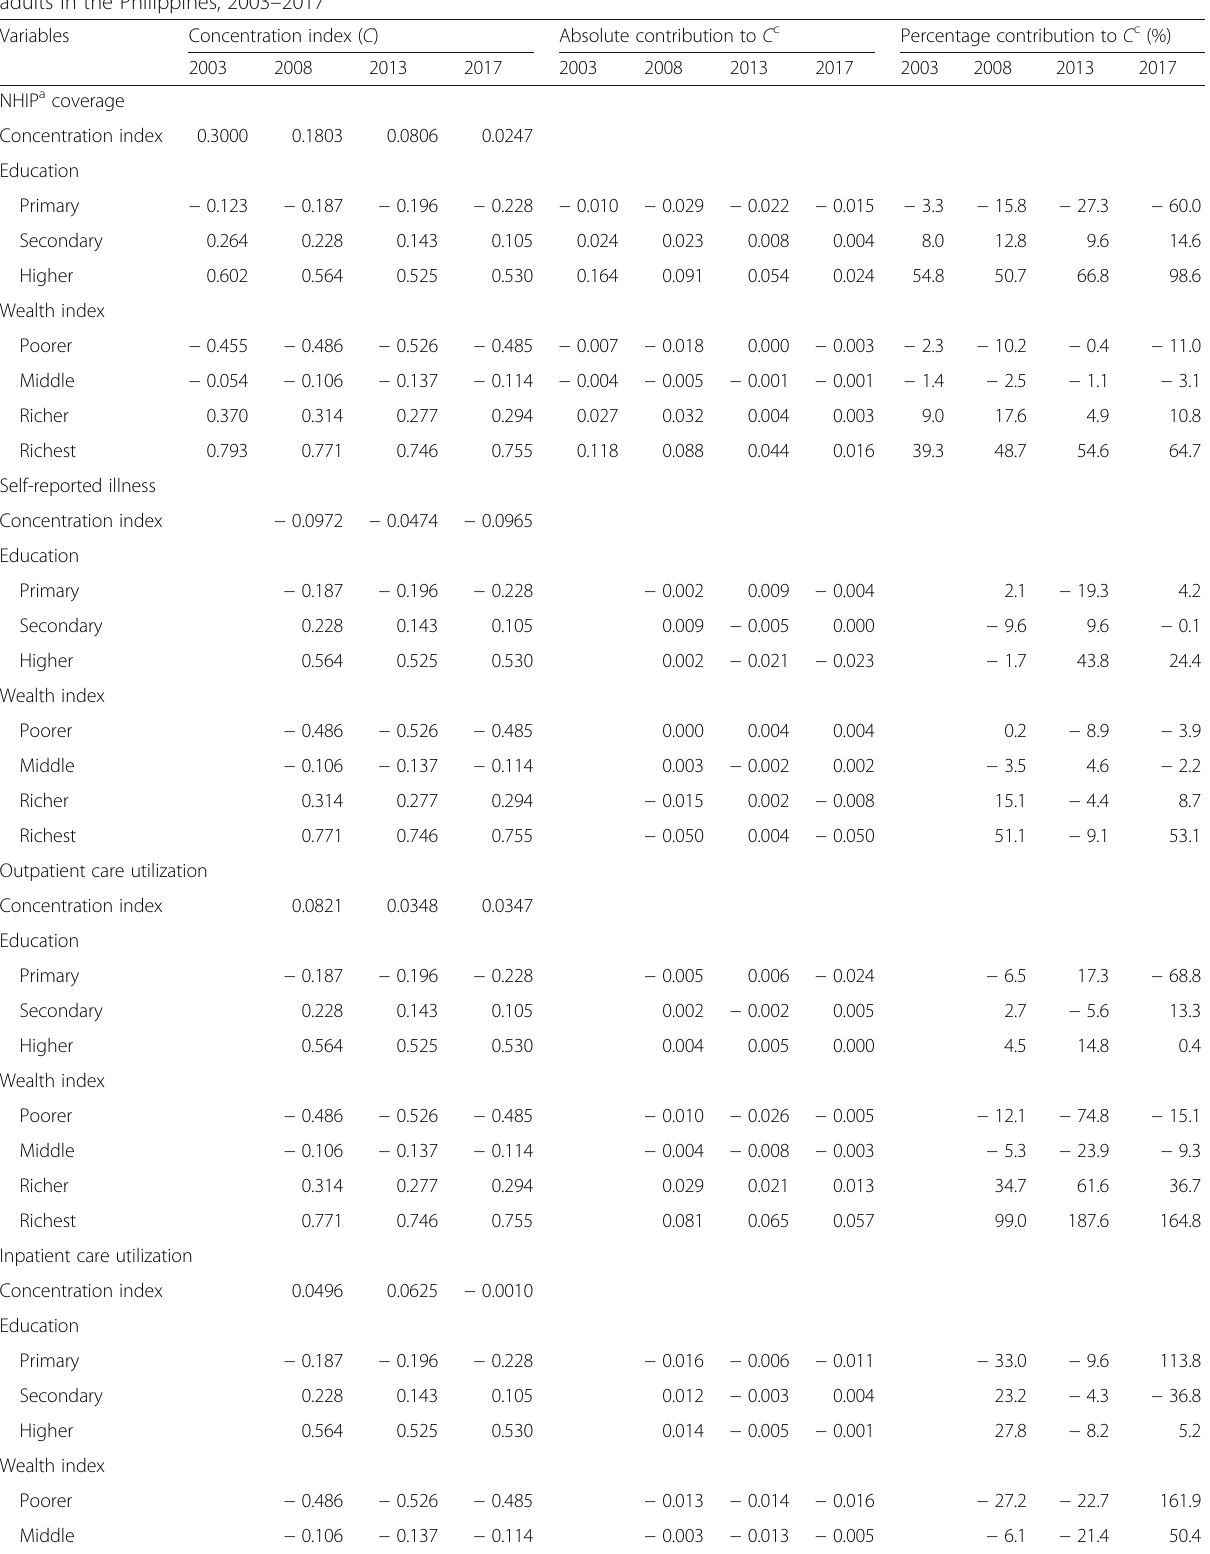
Table 3 Decomposition analysis of inequalities in NHIP a coverage, self-reported illness, and healthcare utilization b among older adults in the Philippines, 2003 –